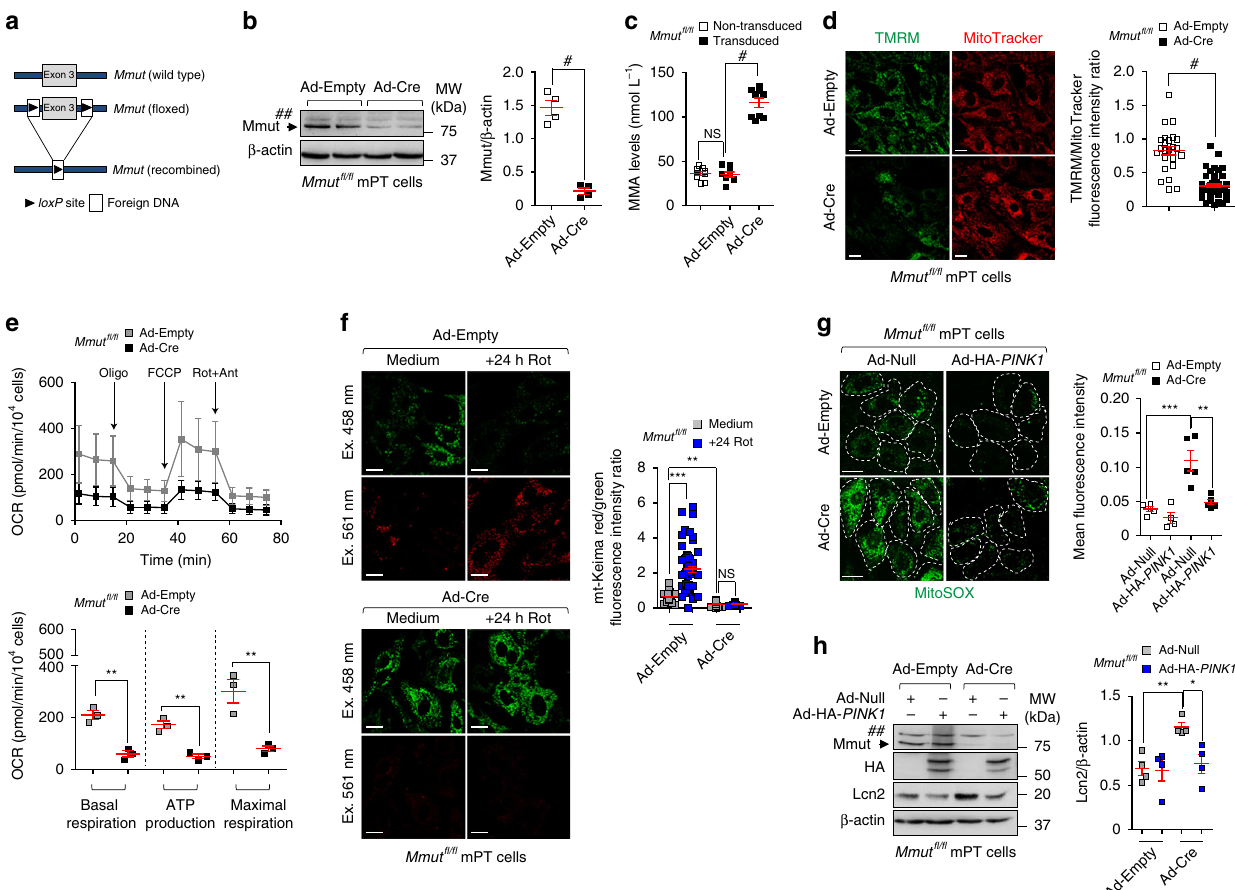
Fig. 7 MMUT deletion damages mitochondria and blunts PINK1-directed mitophagy triggering epithelial stress in kidney cells. a – i Mouse proximal tubule (mPT) cells from fl oxed Mmut kidneys were transduced with adenovirus bearing Empty or Cre-recombinase for 5 days. a Work fl ow of strategy used to generate the fl oxed Mmut alleles. b , c Validation of Mmut deletion by b immunoblotting ( n = 4 biologically independent experiments) and c by LC-MS/ MS analysis of MMA levels ( n = 9 replicates pooled from three biologically independent experiments). d Cells were loaded with TMRM (green) and MitoTracker (red). Confocal microscopy-based quanti fi cation of fl uorescence intensity ratio in a cell. Number of cells transduced with Ad-Empty ( n = 25) or Ad-Cre ( n = 45). e Oxygen consumption rate (OCR) and individual parameters for basal respiration, ATP production and maximal respiration. OCRs were measured at baseline and after the sequential addition of Oligomycin (Oligo, 1 μ M), FCCP (0.5 μ M) and Rotenone (Rot, 1 μ M) + Antimycin A (Ant, 1 μ M). f Mmut cells were transduced with adenovirus expressing mitochondrially targeted form of Keima (mt-Keima) for 24 h and exposed to Rotenone (Rot, 5 μ M for 24 h). Representative images and quanti fi cation of red/green fl uorescence intensity ratio in a cell. Number of untreated ( n = 68) and Rot- treated ( n = 57) control cells, and number of untreated ( n = 51) and Rot-treated ( n = 58) Mmut -deleted cells. g , h Control and Mmut -deleted cells were transduced with adenovirus expressing Null or HA- PINK1 for 24 h. g Cells were loaded with MitoSOX (green) and analysed by confocal microscopy. Representative images and quanti fi cation of MitoSOX fl uorescence intensity, n ≥ 4 randomly selected and non-overlapping fi elds of views per condition, with each containing ~10 cells. h Representative immunoblotting and quanti fi cation of Lcn2, n = 4 biologically independent experiments. β -actin was used as a loading control. Values in d – g are pooled from three biologically independent experiments. Plots represent mean ± SEM. Asterisks denote non-speci fi c bands in b and h . Two-tailed Student ’ s t -test, * P < 0.05, ** P < 0.01, *** P < 0.01 and # P < 0.0001 relative to control cells in b – e or relative to control or Mmut - deleted cells transduced with Ad-Null in h . One-way ANOVA followed by Bonferroni ’ s post hoc test, ** P < 0.01 and *** P < 0.001 relative to untreated control cells or relative to control or Mmut -deleted cells transduced with Ad-Null in f and g . Scale bars,10 μ m. NS non-signi fi cant. Source data are provided as a Source Data fi with adenovirus particles bearing Cre-recombinase to con- damage (Lcn2 overproduction; Fig. 7h), which were abolished by ditionally delete Mmut in vitro (Fig. 7a, b). restoring PINK1-directed mitophagy with an adenovirus expres- The deletion of Mmut was re fl ected by augmented levels of sing (HA)-tagged PINK1 (Fig. 7g, h; Supplementary Fig. 9e). MMA (Fig. 7c), and by reduced engulfment of damaged and/or Conversely, CRISPR/Cas9-mediated KO of PINK1 or PRKN2 dysfunctional mitochondria (e.g. decreased membrane potential (encoding Parkin) in human HAP-1 cells (Supplementary Fig. 10) and altered bioenergetics pro fi ling; Fig. 7d, e) within autolyso- led to mitochondrial alterations, i.e. decreased membrane potential somes (as scored by reduced mt-Keima red/green fl uorescence (Supplementary Fig. 11a), reduced bioenergetics pro fi ling and ratio; Fig. 7f). Under these conditions, Mmut -deleted cells showed elevated mitochondrial ROS production (Supplementary Fig. 11b, no signi fi cant increase in overall mitochondrial proteins com- c), which were similar to, albeit milder than, those encountered in pared to control cells (Supplementary Fig. 9d). In line with patient-and-in Mmut -deleted cells. Notably, we did not detect defective mitochondrial disposal, Mmut -deleted PT cells exhib- any differences in mitochondrial morphology between PINK1 ited elevated mitochondrial oxidative stress (Fig. 7g) and cell and PRKN2 wild type and KO cells (Supplementary Fig. 11d).